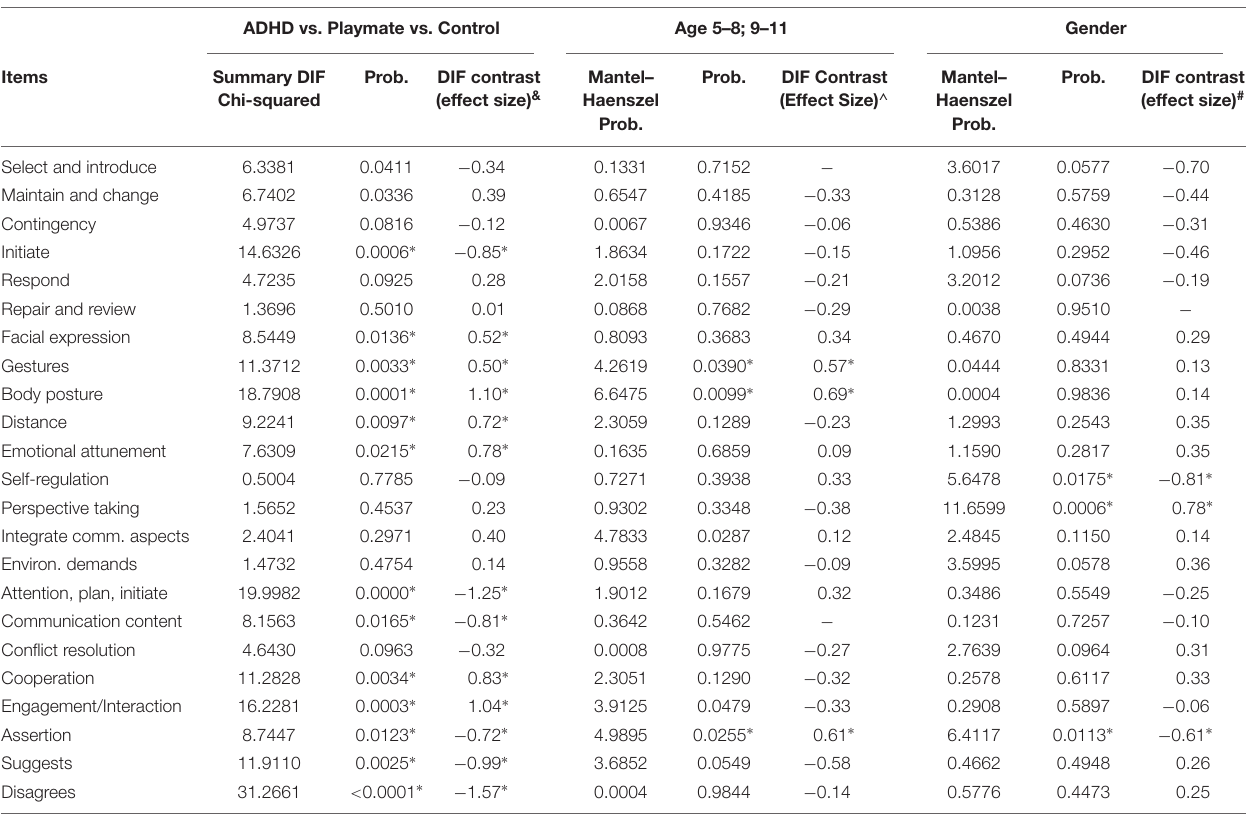
TABLE 8 | Summary DIF analysis. ADHD vs. Playmate vs.